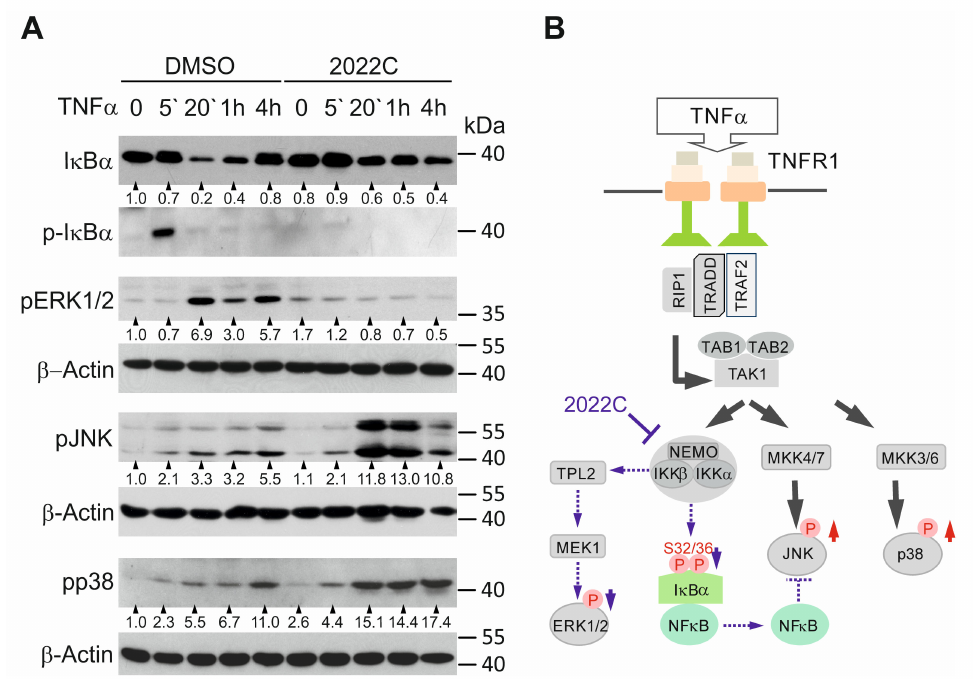
Figure 4. NAE_2022C inhibits TNF α -induced NF- κ B and ERK1/2 activation by targeting the IKK complex. ( A ) HaCaT cells were stimulated with 0.75 ng mL − 1 TNF α for different times, as indi- cated in the presence or absence of 10 µ g mL − 1 NAE_2022C. Cells were analyzed by immunoblot- ting using the indicated antibodies. The intensity of the bands was analyzed using Image J, as in Figure 3B. ( B ) Schematic representation of the TNFR/NF- κ B pathway. Inhibition of the IKK complex by NAE_2022C is indicated. Blue and red arrows represent a decrease and increase in protein phos- phorylation, respectively. Dashed arrows indicate the NAE_2022C-mediated inhibition of signaling events downstream of